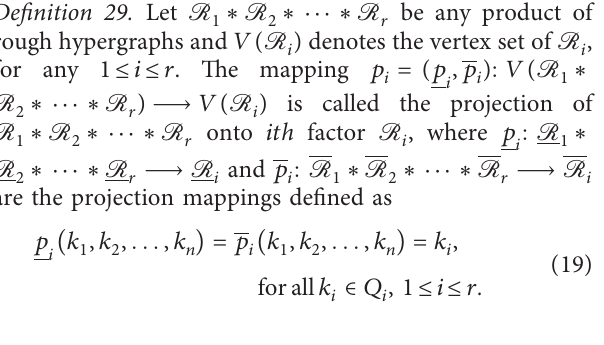
Figure 8: Hypergraph H